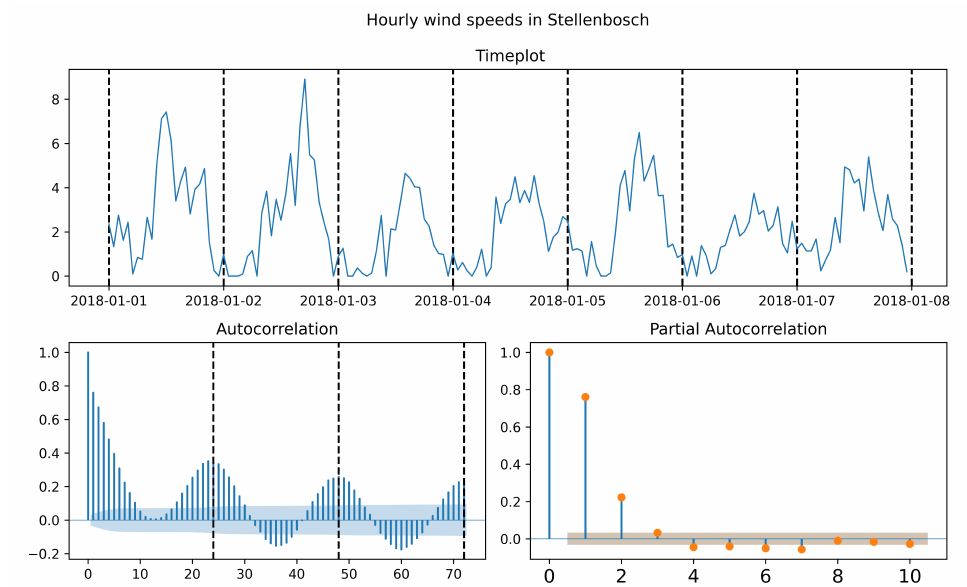
Figure 8. Timeplot, autocorrelation function (ACF), partial autocorrelation function (PACF) of hourly wind speed measurements in Stellenbosch.